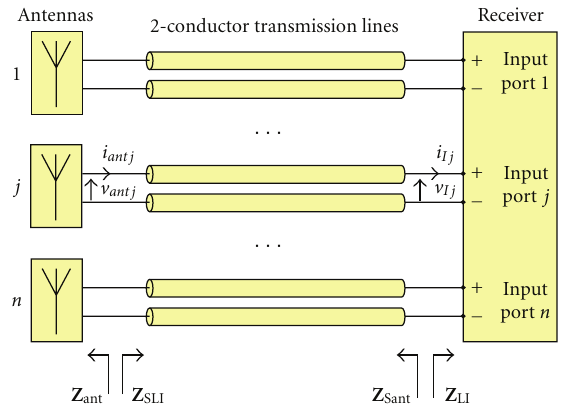
Figure 1: An array of n antennas connected to n uncoupled 2- conductor transmission lines connected to a wireless receiver having n input